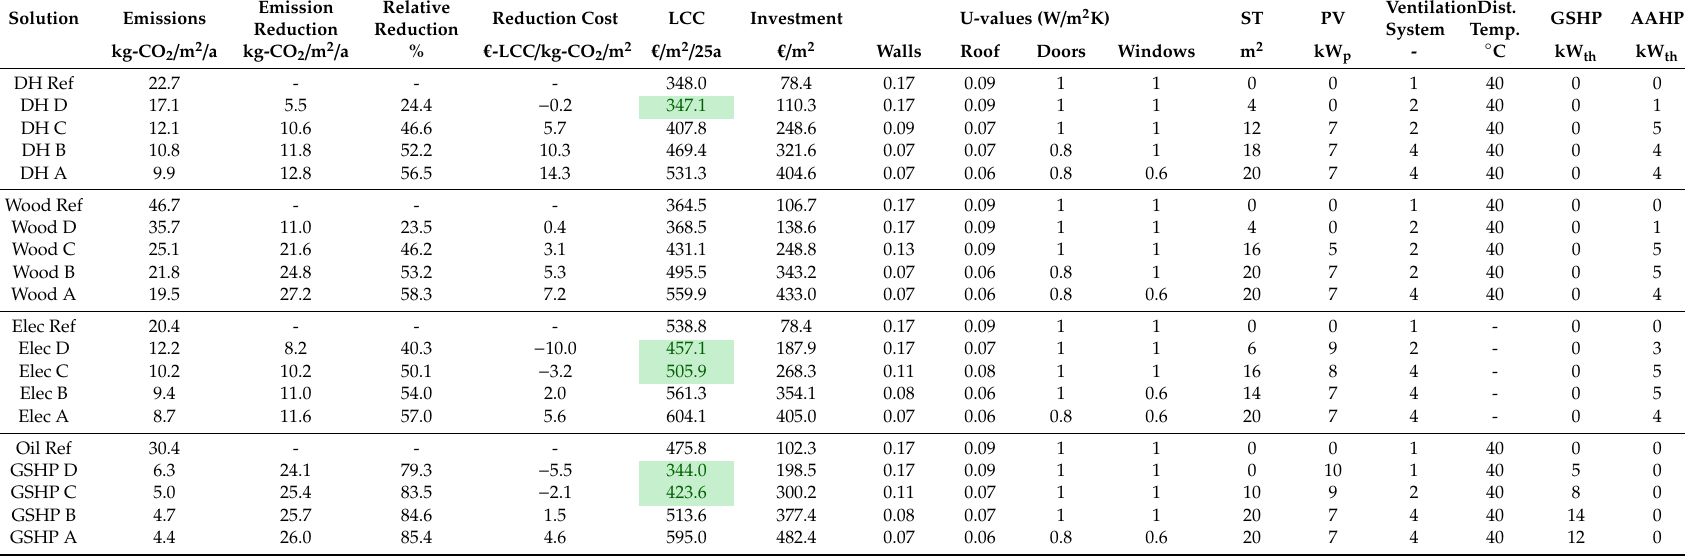
Table 14. Selected optimal cases for SH4 with all heating systems. Cost-e ff ective solutions are marked in green. Cases D to A are optimized solutions from the lowest to the highest LCC. For the ventilation system: 1 is mechanical supply and exhaust ventilation with 65% HR e ffi ciency, 2 is mech. S & E ventilation with 65% HR and VAV, 3 is mech. S & E ventilation with 75% HR, and 4 is mech. S & E ventilation with 75% HR and VAV.